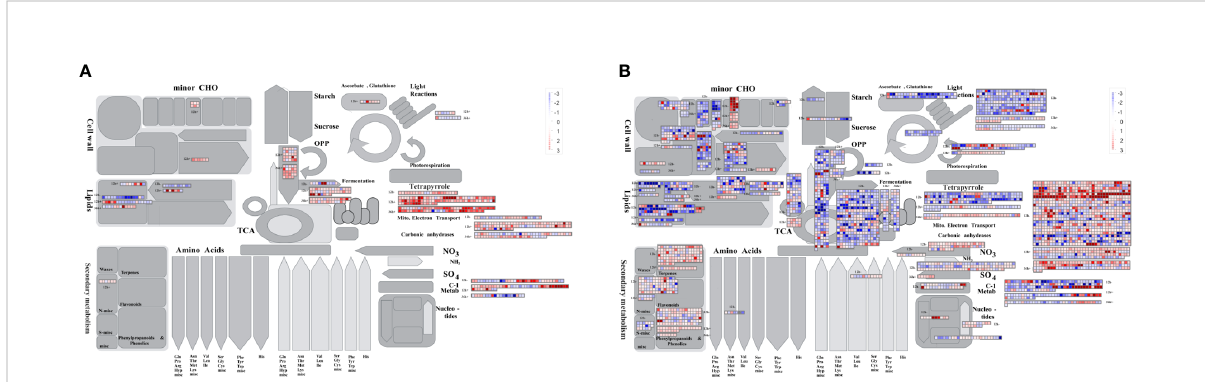
FIGURE 8 Visualization of DEGs of pairwise comparisons within the entire WR_ q cri vs. CK set (A) and WR_SD vs. CK (B) set enriched in metabolism pathways. The list of gene identi fi ers and log2FC values from each treatment were imported into MapMan software version 3.5.1R2 and assigned to functional categories using the strawberry mapping fi le obtained by Mercator